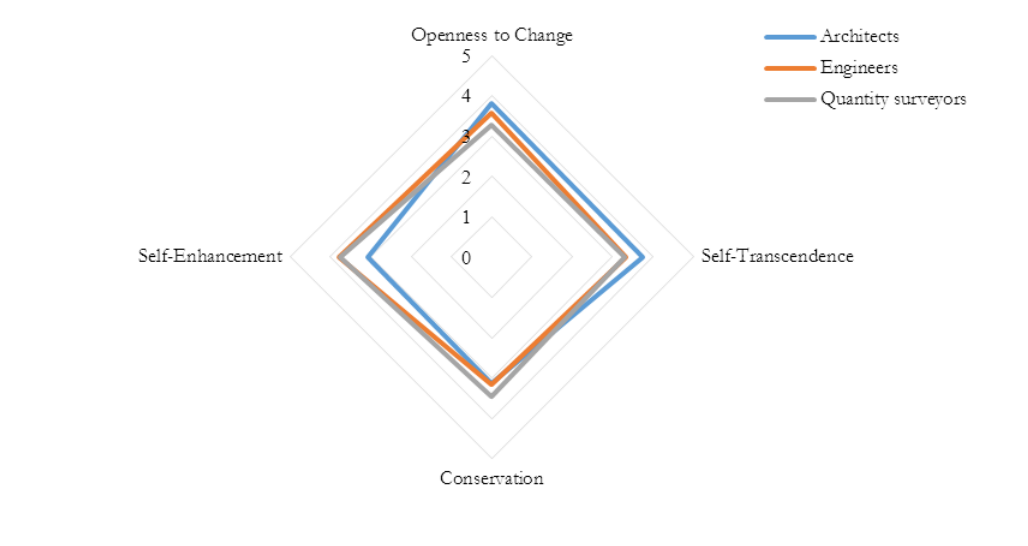
Figure 3: Comparing the professions based on the 4 higher-order value